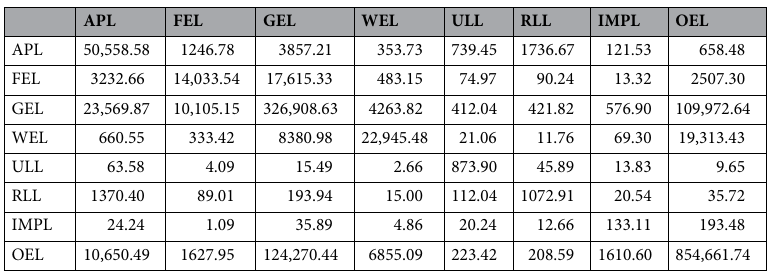
Table 4. Land use transition matrix in Xinjiang from 2000 to 2020 (km 2